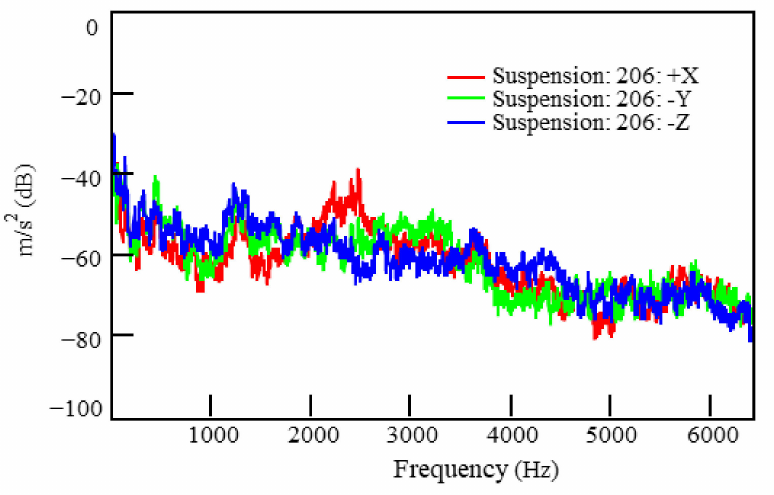
Figure 19. Excitation spectra on the front of the left rear suspension spring (in three directions from Connection Point